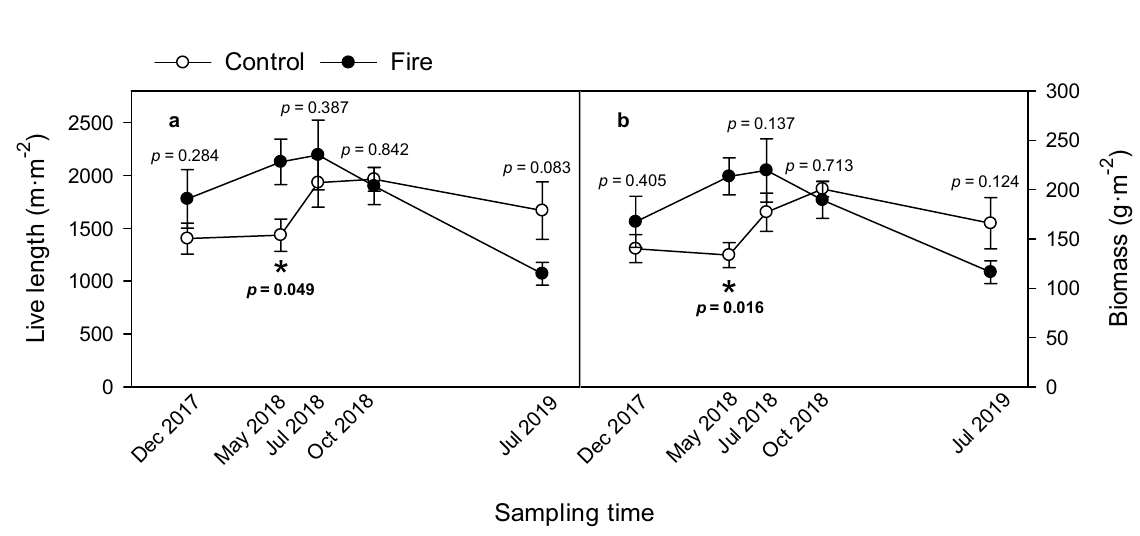
Figure 3. The significant interactions of fire × sampling time on live fine root length (m·m −2 ) ( a ) and standing biomass (g·m −2 ) ( b ) for Root Class 2 (0.3–1.0 mm). For control ( ○ ; n = 8) and fire-affected ( ● ; n = 6) trees, significant differences ( p < 0.05) determined by paired t-test and shown in bold with an